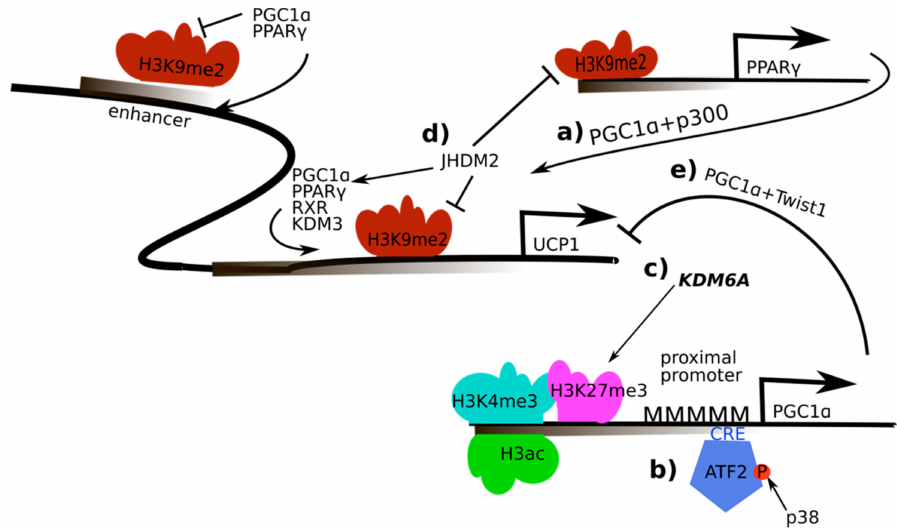
Figure 2. Regulation and activity of PGC-1 α in the regulation of UCP-1 in brown adipose tissue and thermogenesis: a) PGC-1 α recruits peroxisome proliferator-activated receptor γ (PPAR γ ) and sterol-receptor coactivator 1 / E1A binding protein (SRC-1 / p300) to regulatory elements of the uncoupling protein 1 ( UCP-1 ) gene; b) AMP-dependent transcription factor (ATF-2) is recruited to cAMP response element (CRE) elements in the PGC-1 α promoter upon phosphorylation by the p38 mitogen-activated protein kinase which enables PGC-1 α transcription; c) Histone 3 lysine 27 (H3K27) is demethylated by H3K27 lysine-specific demethylase 6A (KDM6A), higher acetylation of H3K27 subsequently leads to enhanced PGC-1 α gene expression; d) interaction of PGC-1 α with the JmjC domain-containing histone demethylase 2 (JHDM2) a ff ects the recruitment of the PPAR γ complex containing retinoid X receptor α (RXR α ), PGC-1 α , p300 and SRC-1 to the PPAR-response